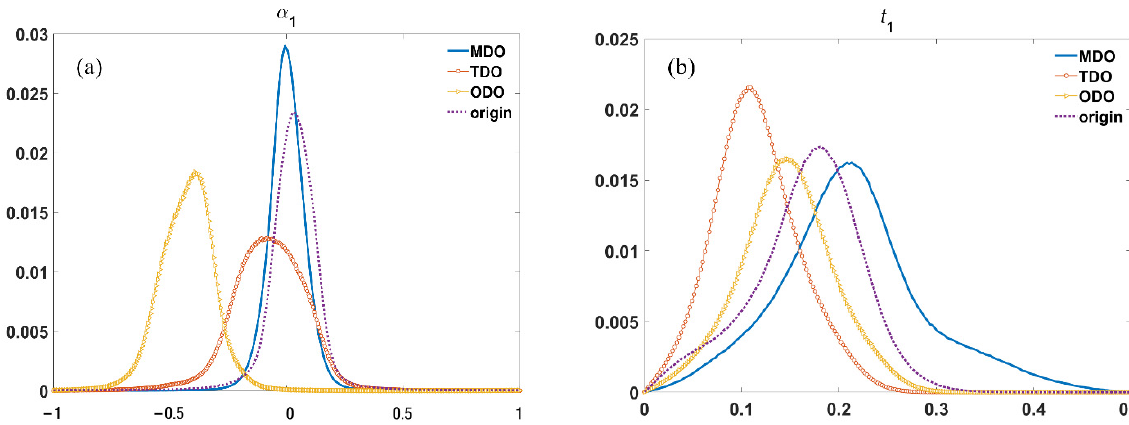
Figure 5. FDHs of MMT parameters ( a ) α 1 and ( b ) t 1 for the tendon tissues in four different states. The horizontal axis is divided into 400 intervals, and the vertical axis coordinates represent the probability that the data points fall into one of the intervals of the horizontal axis.